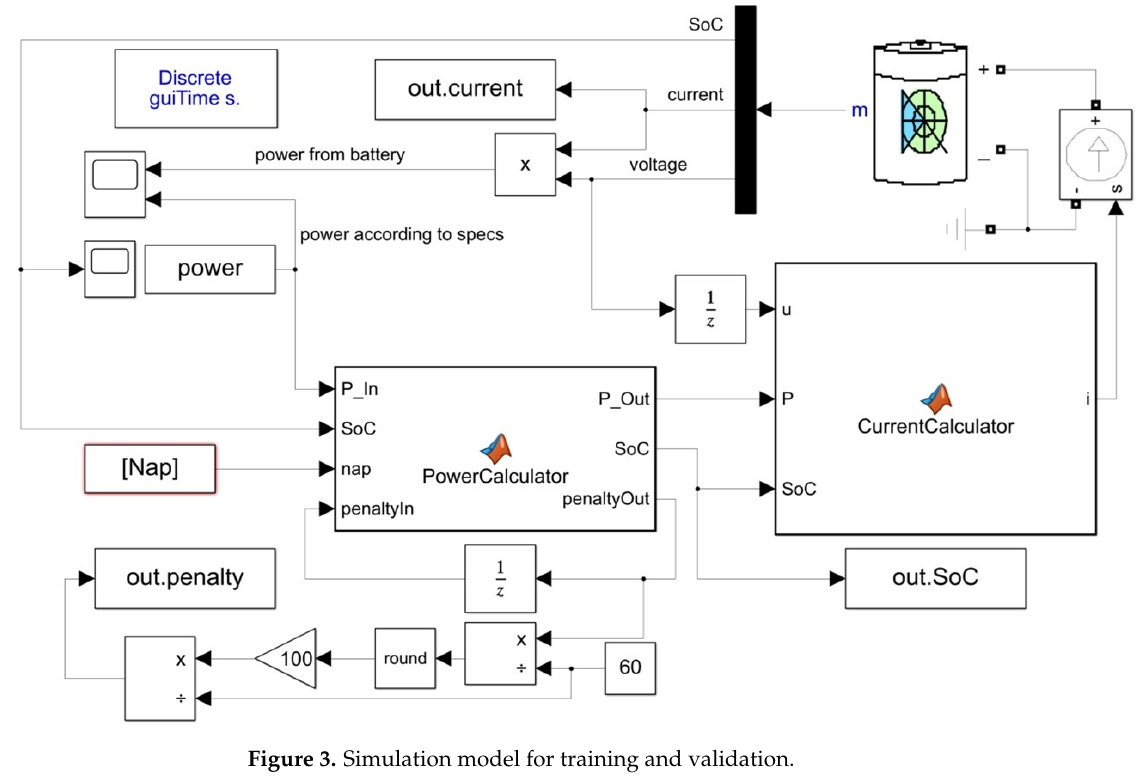
Figure 3. Simulation model for training and validation.